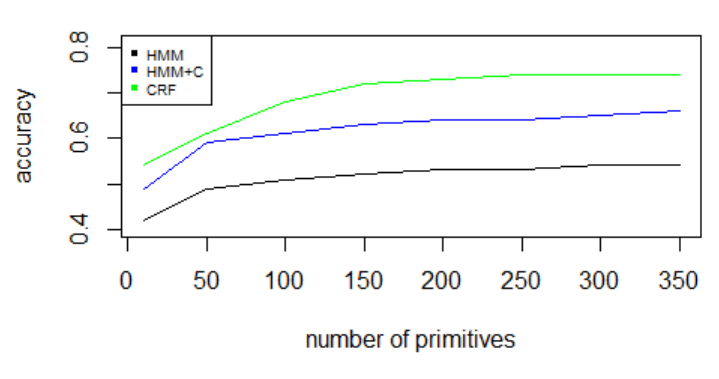
Figure 7. Accuracy as number of primitives increase.